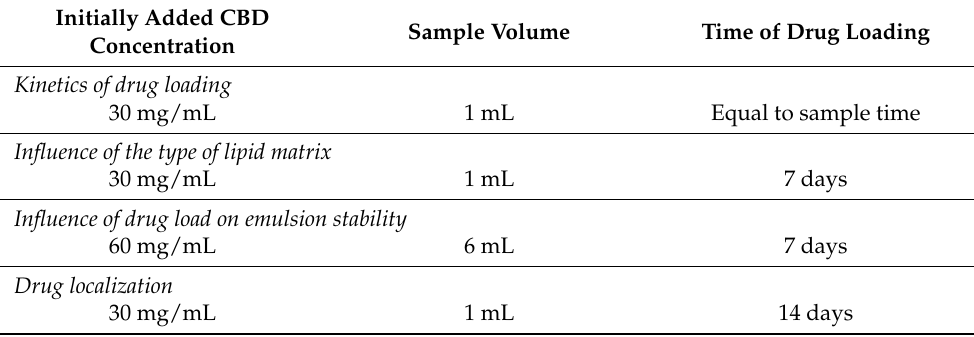
Table 3. Parameters applied for drug loading procedures.